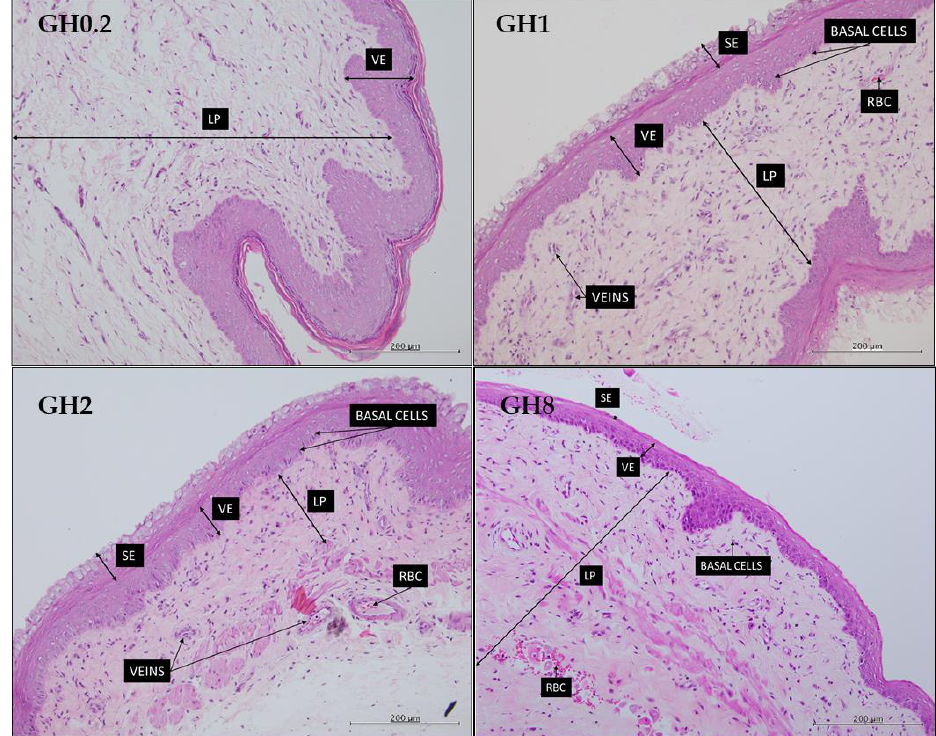
Figure 7. Structure of the rat vaginal epithelium following a 14-day administration of Gelam honey (GH) at different doses. The vaginal epithelium became thinner and the squamous epithelium, which makes up the mucosal layer, became less pronounced with an increasing dosage of GH. GH0.2 (0.2 g GH/kg bw/day); GH1 (1 g GH/kg bw/day); GH2 (2 g GH/kg bw/day); GH8 (8 g GH/kg bw/day). VE: vaginal epithelium; LP: lamina propia; RBC: red blood cells; SE: squamous epithelium. The tissues were stained with an H&E stain. All measurement bars are equivalent to 200 µ